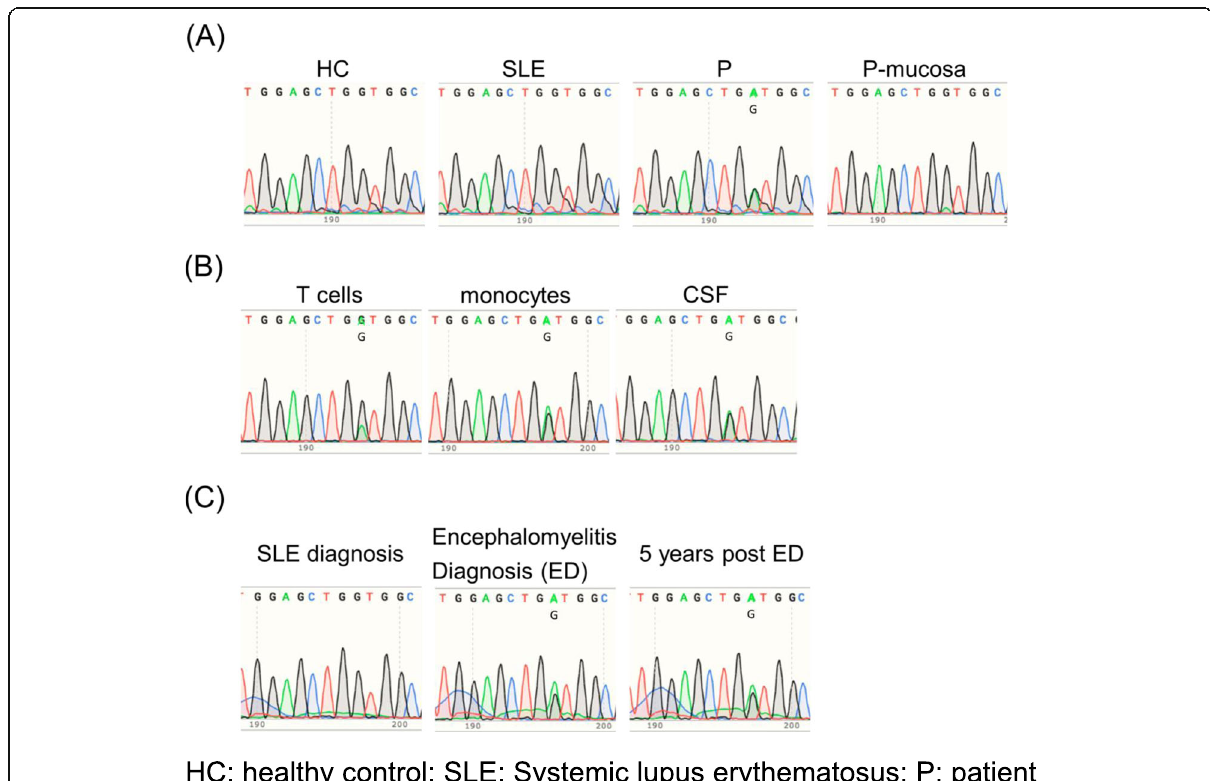
Fig. 4 Sanger sequence results of Kras. A T he chromatograms are showing wild type Kras DNA in the PBMC of healthy control (HC), and in another patient with systemic lupus erythematosus (SLE), whereas mutated Kras (c.G35A) DNA was detected from PBMC of the patient (P). The same mutation is not detected in mucosa of the patient of interest (P-mucosa). B The chromatograms are showing the same mutation site of Kras from sorted T cells, monocytes and cerebrospinal fluid (CSF). C Kras genomic sequence of the patient was wild type when she was diagnosed with SLE. However, Kras mutation (c.G35A) manifested spontaneously at the time when she developed encephalomyelitis, and persisted for 5 years after the encephalomyelitis diagnosis